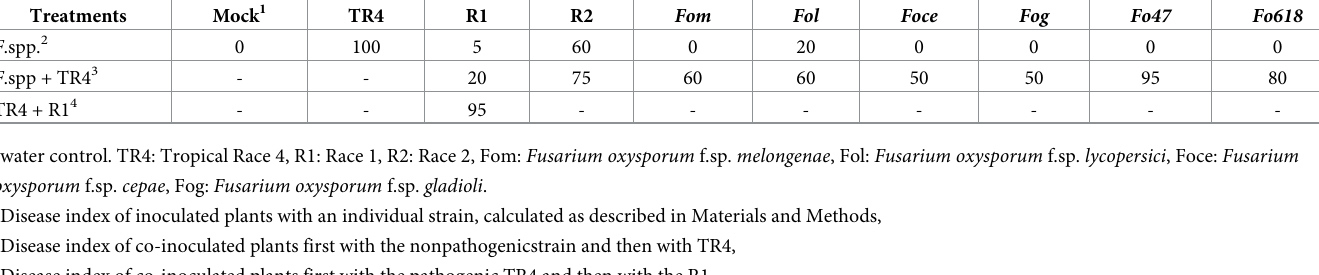
Disease index of inoculated plants with an individual strain, calculated as described in Materials and Methods, 3 Disease index of co-inoculated plants first with the nonpathogenicstrain and then with TR4, 4 Disease index of co-inoculated plants first with the pathogenic TR4 and then with the